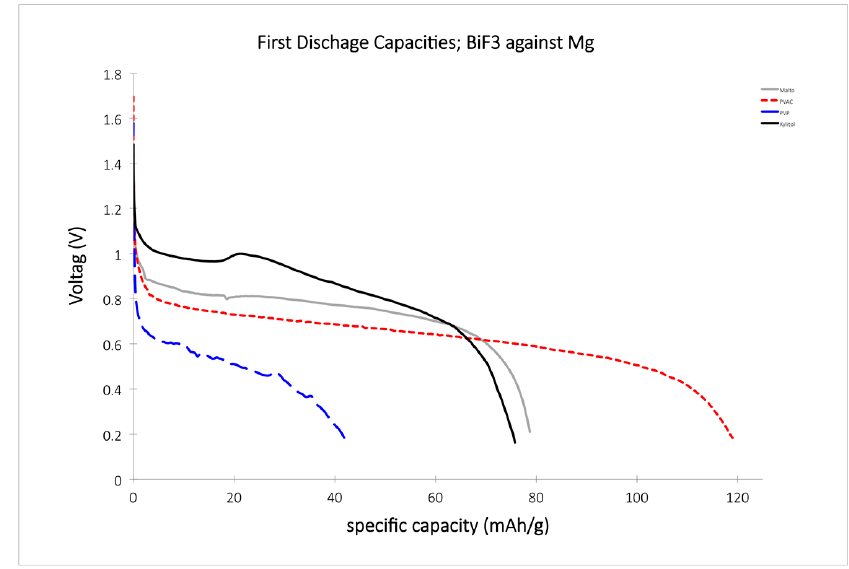
Figure 7. Discharge curves for the various fluoride-doped polymer compounds.